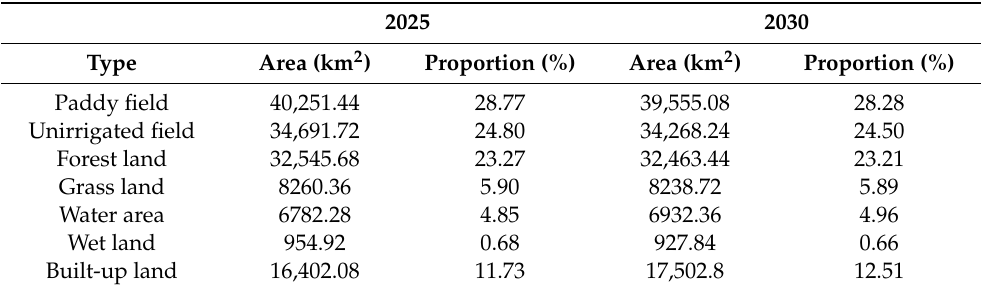
Table 13. Simulation results of land use change in 2025 and 2030.